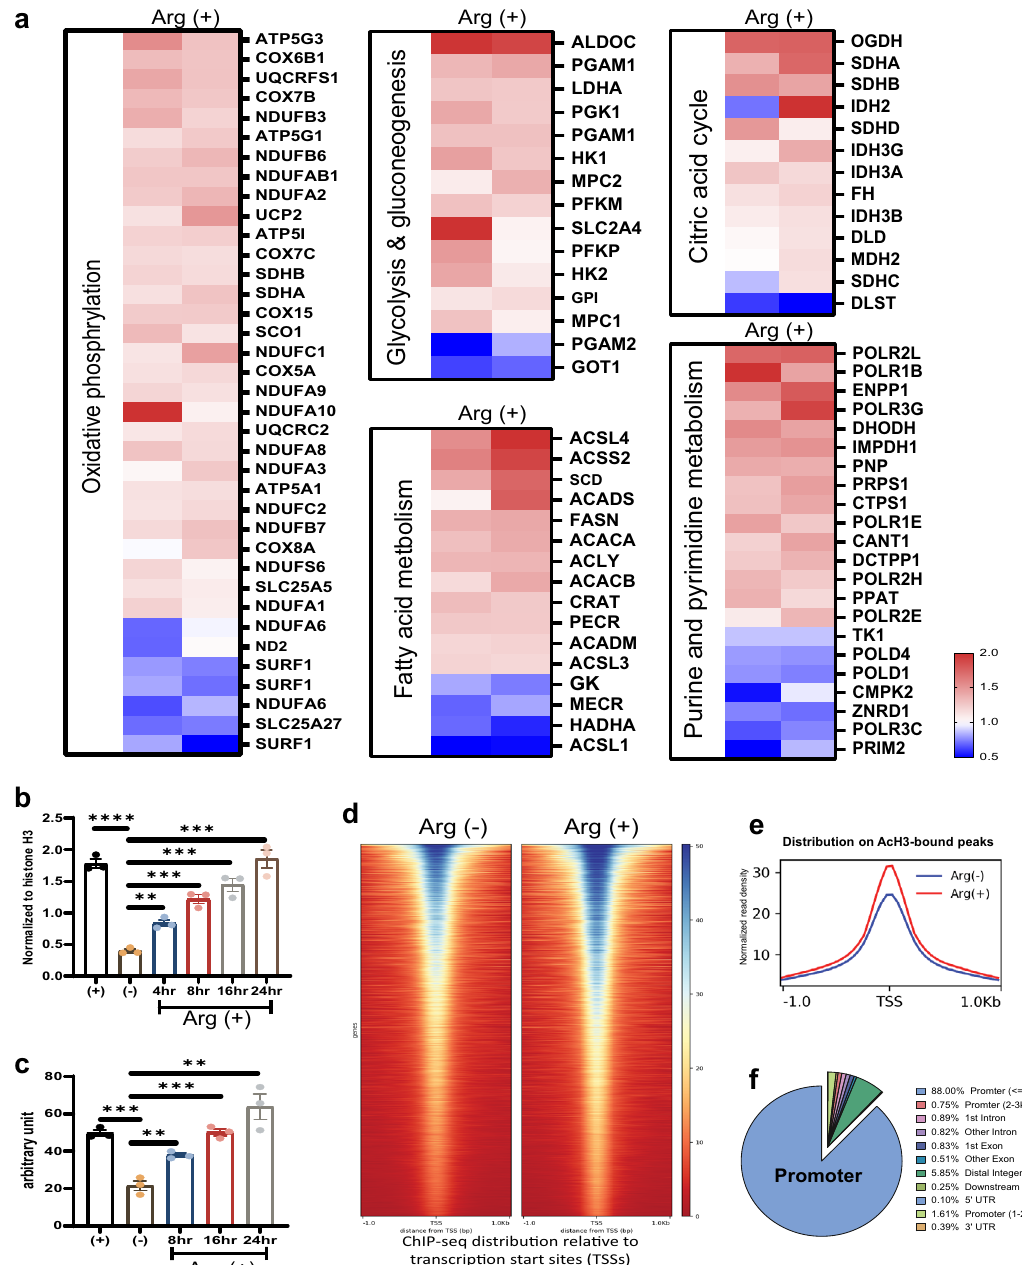
Fig. 1 Arginine globally modulates metabolic gene expression via histone acetylation. a Heat map of Affymetrix microarray analysis shows arginine (Arg + ) globally induced metabolic pathways, including oxidative phosphorylation pathway, glucose, fatty acid, and DNA metabolic pathways in CWR22Rv1 prostate cancer cells. The color key indicates the fold change to control. b After starvation overnight, cells were treated with arginine and then harvested at different time points for total acetyl-histone H3 ELISA assay. This data shows that arginine regulated the total level of histone H3 acetylation at different time points. c After starvation overnight, cells were treated with arginine and then harvested at different time points for total acetyl-CoA assay. ELISA data show that arginine regulated the total level of acetyl-CoA at different time points. d Heat map of acetylated histone H3 ChIP-seq peaks showing that the distribution of peaks are close to transcription star sites (TSS). e Overlap of arginine stimulation Arg ( + ) and arginine deprivation Arg ( − ) ChIP-seq peaks. f Acetylated Histone H3 ChIP-sequencing peaks classi fi ed by human genomic annotation (hg38), showing that the peaks of histone acetylation are mainly enriched in the promoter region of genes. Data are presented as mean values ± SEM of independent experiments ( n = 3 in b , c ). ** p < 0.01, *** p <